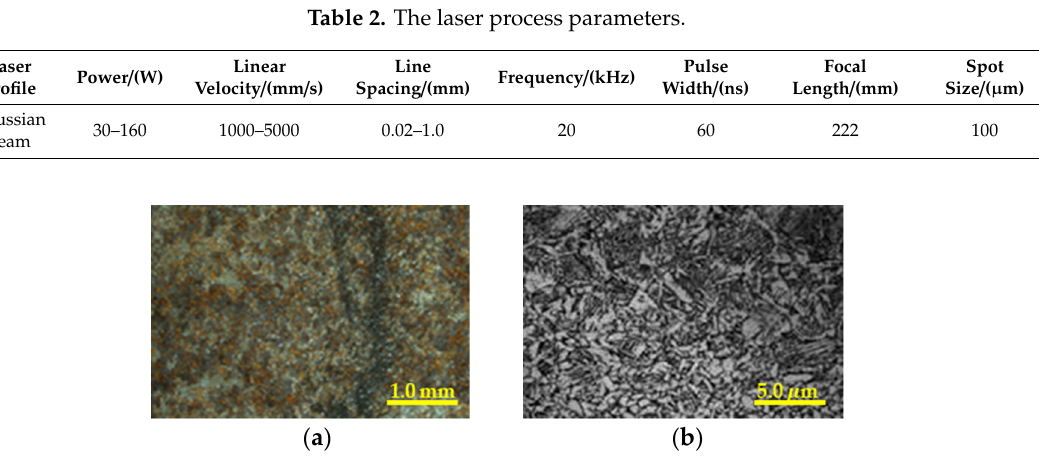
Figure 5. Photos of Q235 carbon steel sample and its microstructure. ( a ) Photo of rusty carbon steel; ( b ) microstructure photo of carbon steel. Table 2. The laser process parameters.